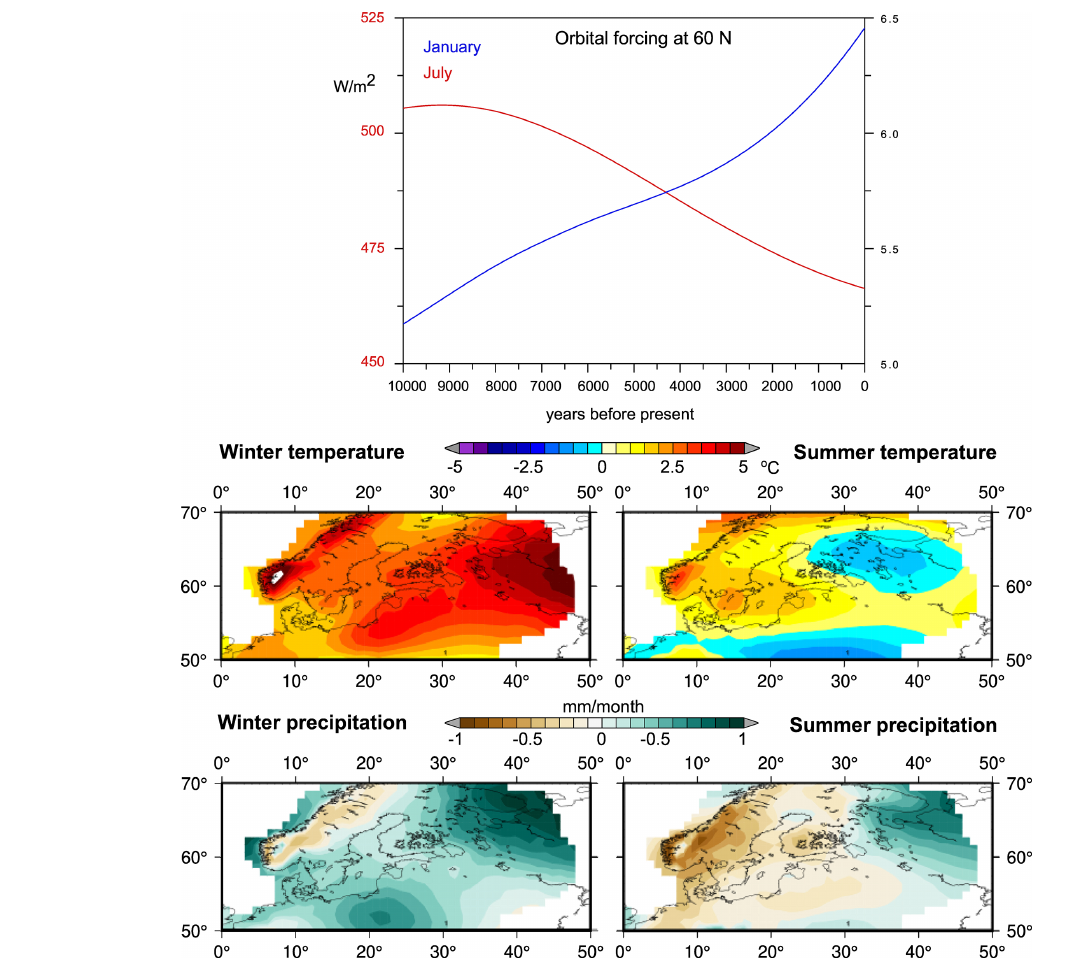
Figure 3. Orbital forcing (irradiance) at 60 ◦ N in January and July and the anomalies of reconstructed seasonal temperature and precipitation compared to preindustrial climate in the Baltic Sea region at the Mid-Holocene Optimum (6000BP). Data source: irradiance data by Laskar et al. (2004) and temperature and precipitation data by Mauri et al. (2015).